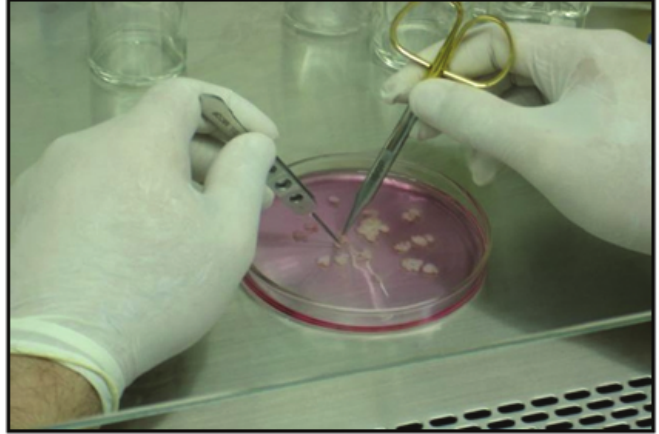
FIGURE 3 - Technique of explants of adipose tissue extracted by